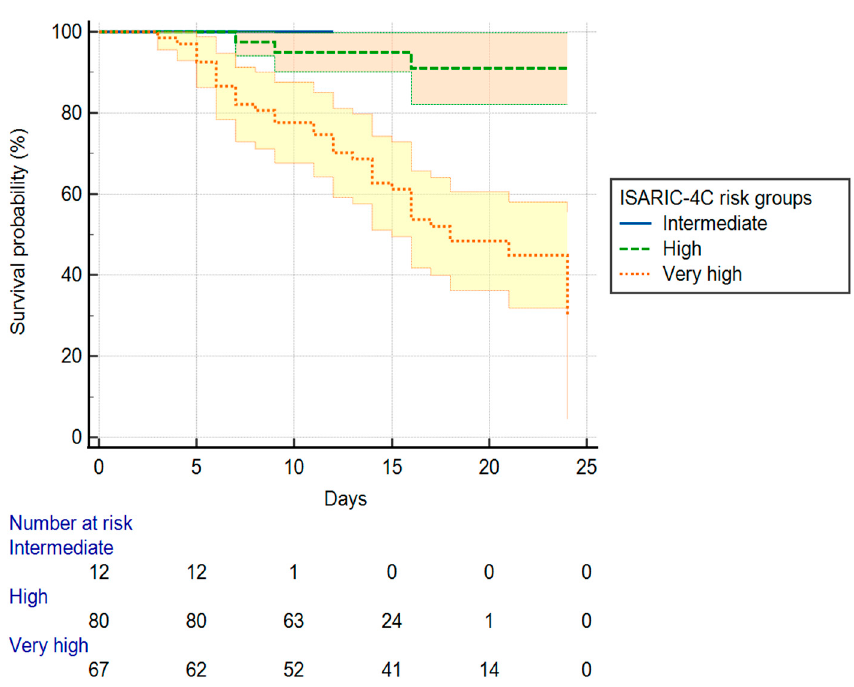
Figure 3. Kaplan–Meier curve of hospitalization days in surviving patients grouped by the ISARIC-4C risk.